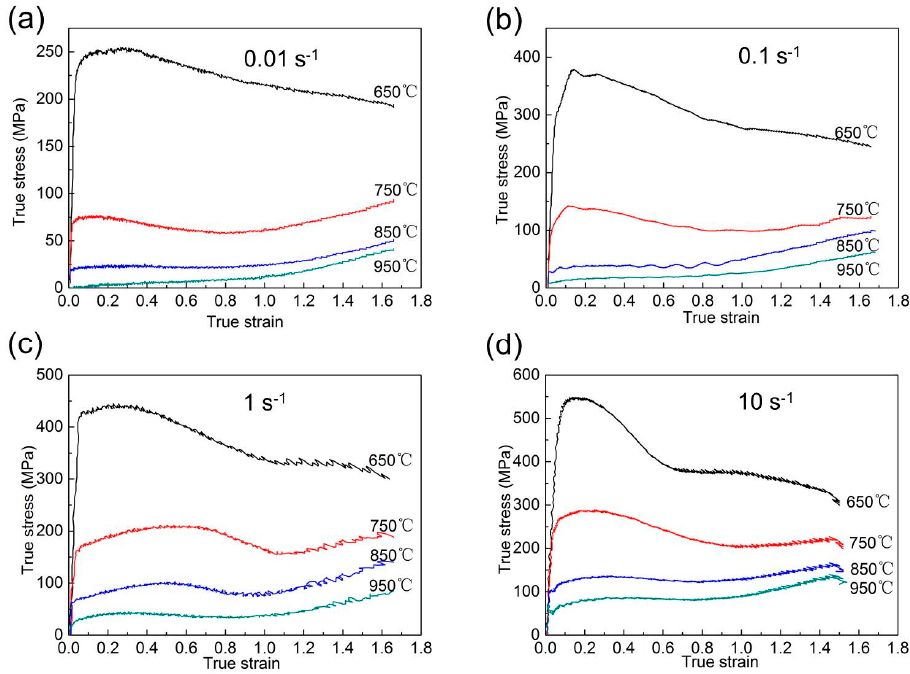
Figure 1. True stress–true strain curves of the Fe-6.5wt. %Si alloy under various deformation conditions: ( a ) 0.01 s − 1 ; ( b ) 0.1 s − 1 ; ( c ) 1 s − 1 ; ( d ) 10 s − 1 .